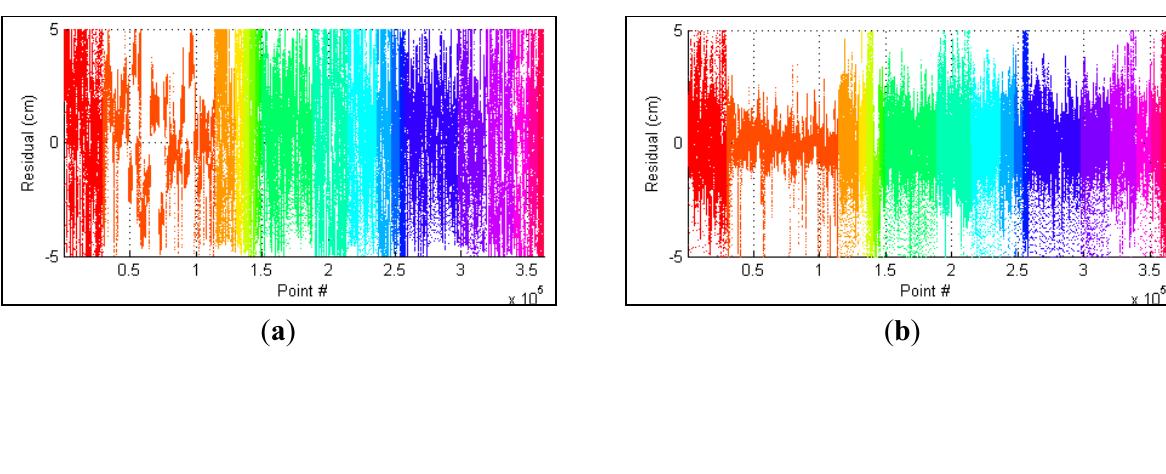
Figure 8. Point residuals colour-coded to show calibration planes ( a ) factory parameters; ( b ) recalibrated